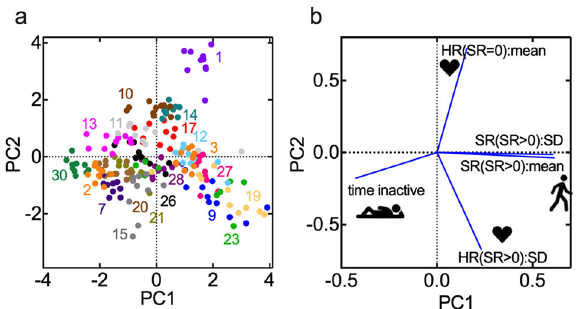
Fig. 2 Principal component analysis. a PCA scatter plot of the fi rst two principal components. For each subject ( N = 20), 10 weeks were randomly selected from the dataset. The variance for the fi rst two principal components were 48.6% and 30.0%, respectively. For 100 independent runs, the mean variance of PC1 and PC2 was 77.5 ± 0.58%. Numbers represent subject IDs. Each point represents one week of data. b Loading plot. HR(SR = 0):mean is the mean value of the heart rate at SR = 0; HR(SR > 0):SD is the standard deviation of the heart rate at SR > 0; SR(SR > 0):mean is the mean step count for SR>0; SR(SR>0):SD is the standard deviation of the step rate for SR > 0; time active is the fraction of minutes with SR =